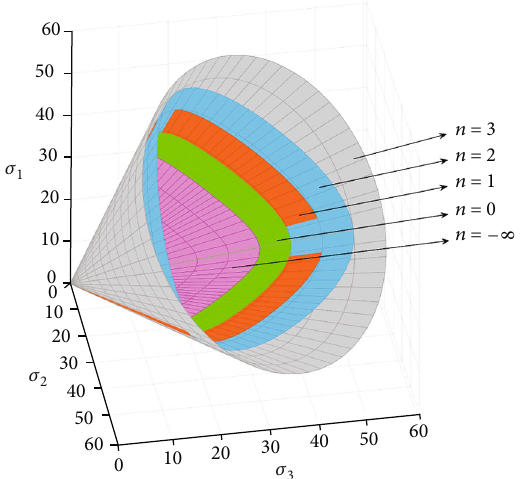
Figure 11: Yield surfaces under di ff erent n